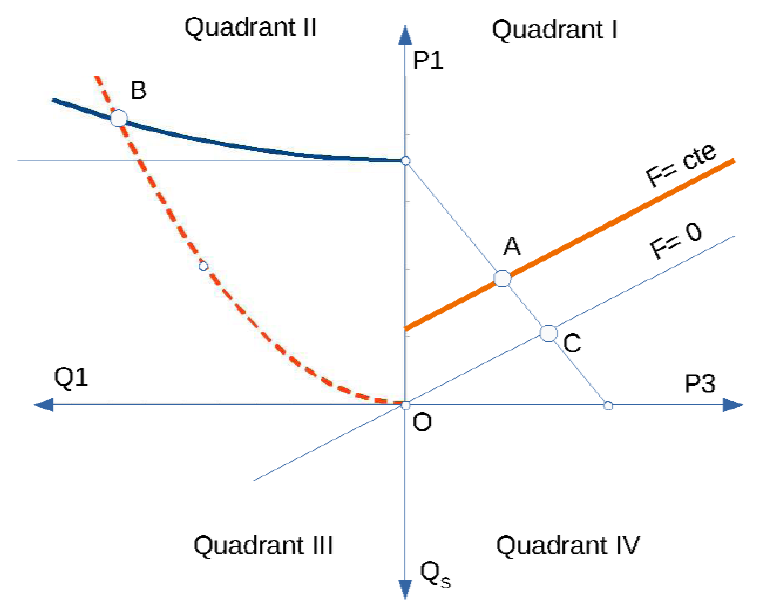
Figure 6. The cartesian plane is divided into four quadrants and characteristic curves of the hydraulic actuator and the load-holding valve. A represents the intersection between the curve of the cylinder function and that of the LHV when the force is constant; B is the intersection between the curve of the operating point of the LHV acting as a relief valve and the flow curve; C is the same as A but zero for the case of zero force.